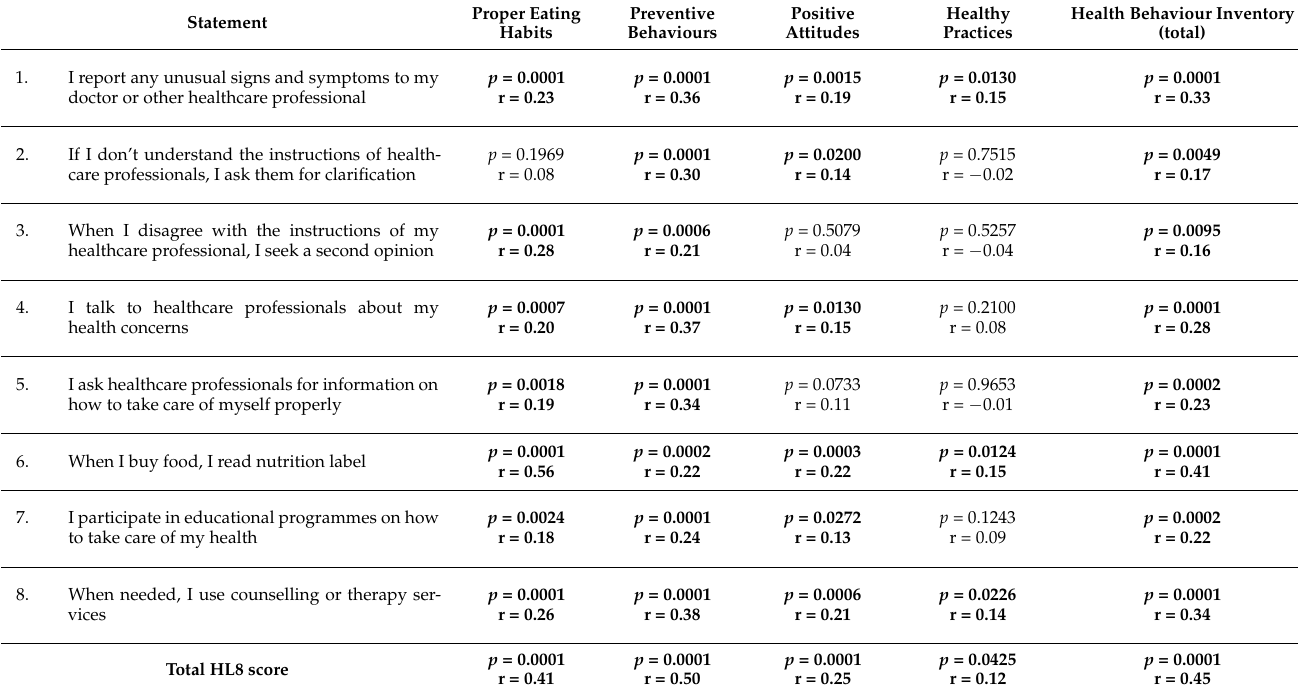
Table 7. Health literacy vs. health behaviours.